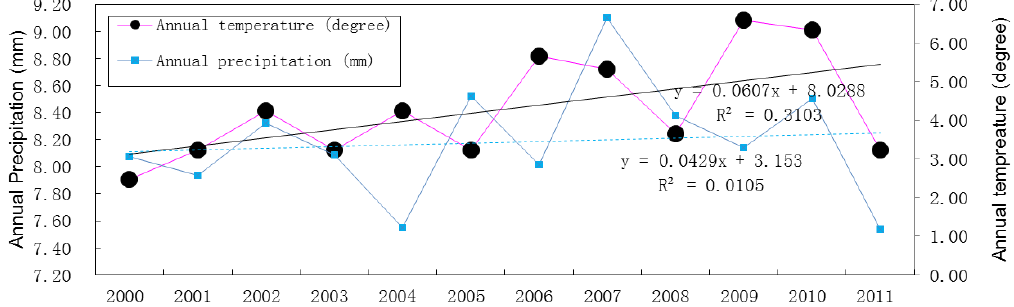
Figure 10. Changes in annual temperature and precipitation in the HRB.